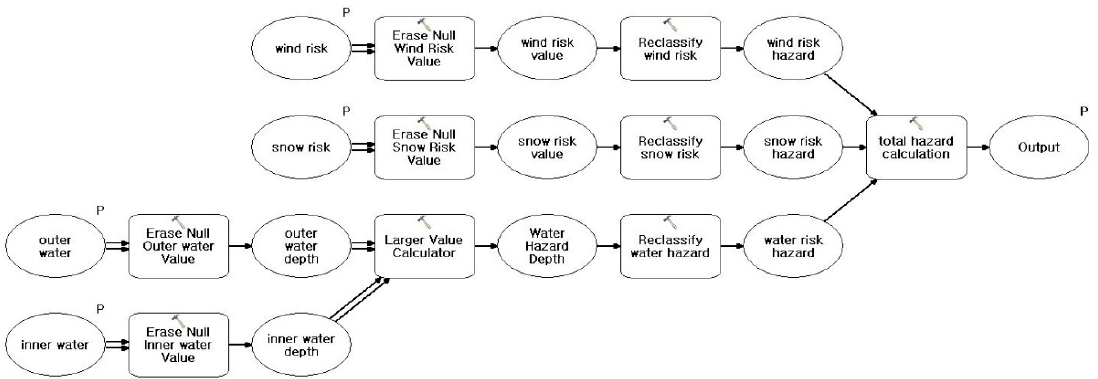
Figure 5. Storm and flood mapping model builder.